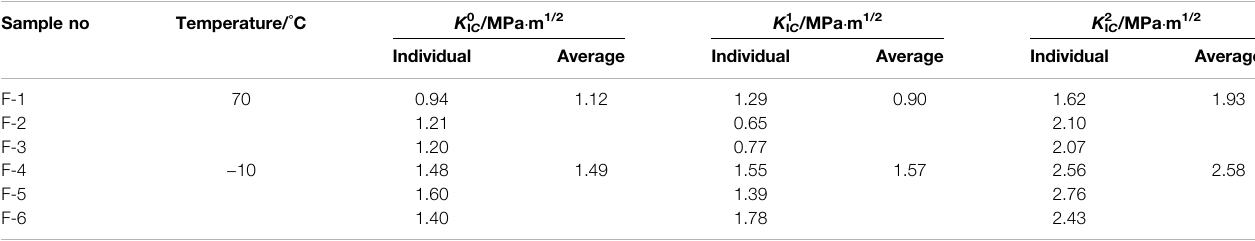
TABLE 4 | Test values of fracture